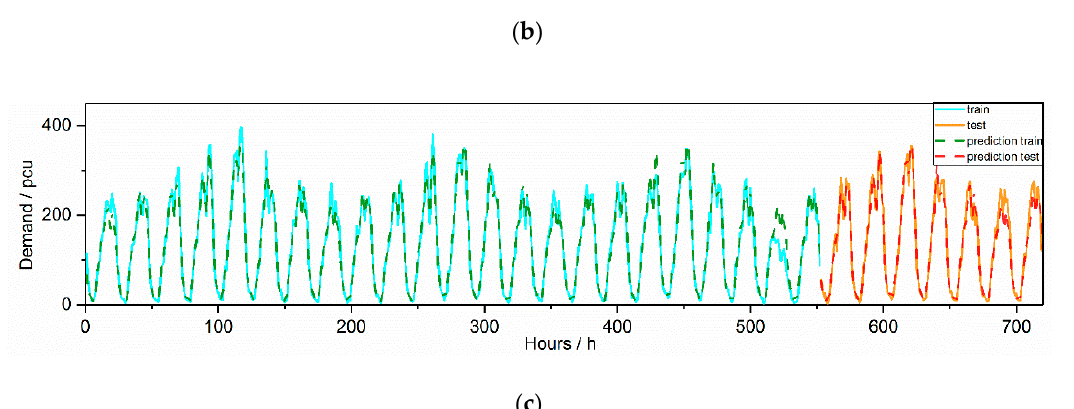
Table 8. Prediction effects of BPNN and XGB.